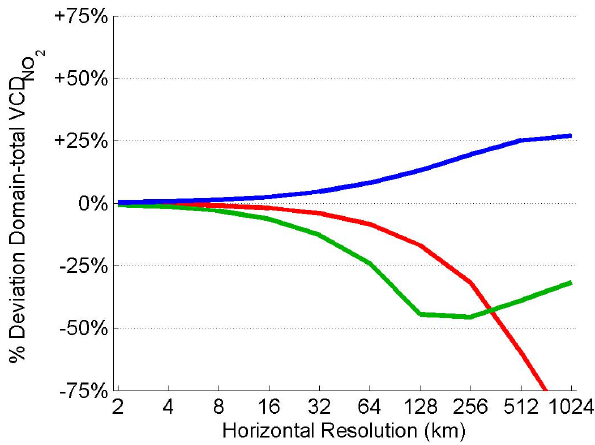
Fig. 3. Resolution-dependent bias in domain-averaged NO 2 column versus model resolution for small (blue), intermediate (green), and large (red) sources of NO 2 in a 1-D plume model (Fig.